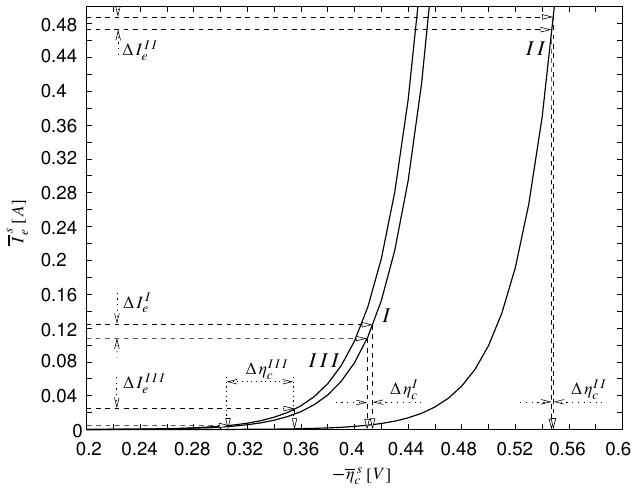
Figure 10. Tafel equation for simulation cases I , II and III